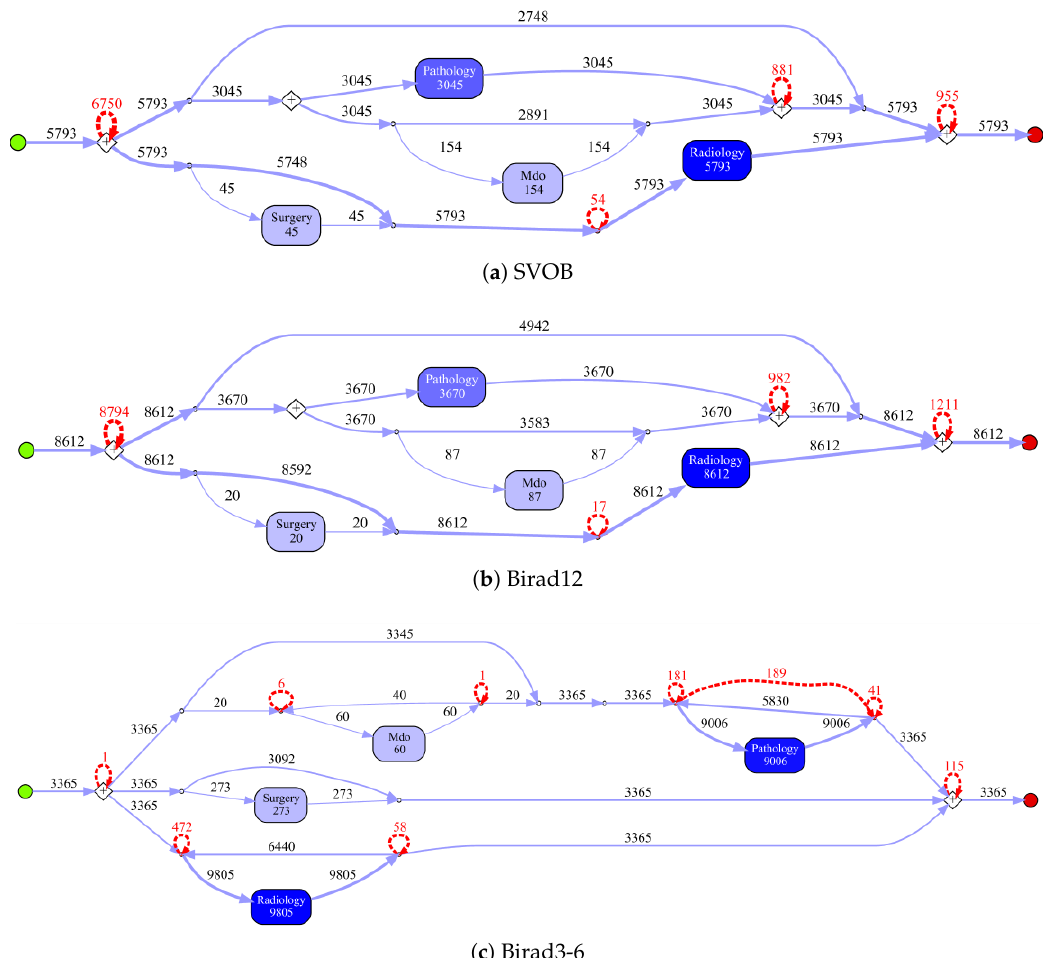
Figure 8. Discovered process models on ZGT for sub-populations with events on level